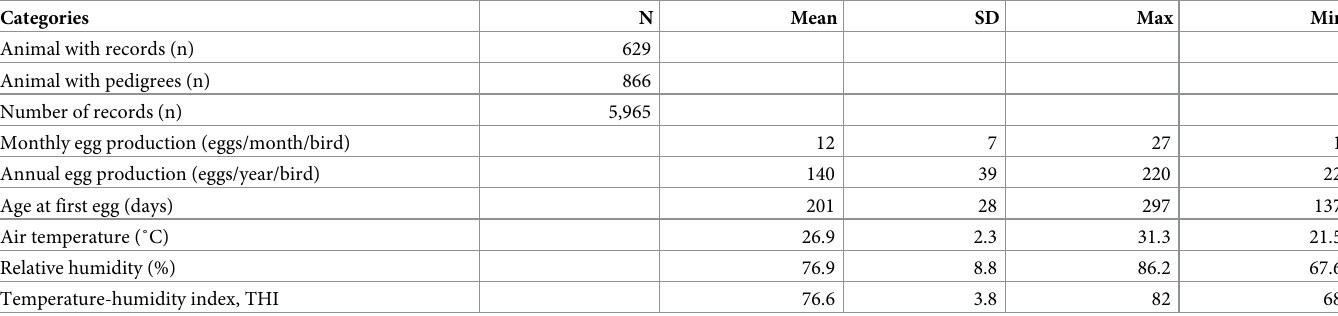
Table 1. Data structure for estimation of variance components for Thai native chickens.